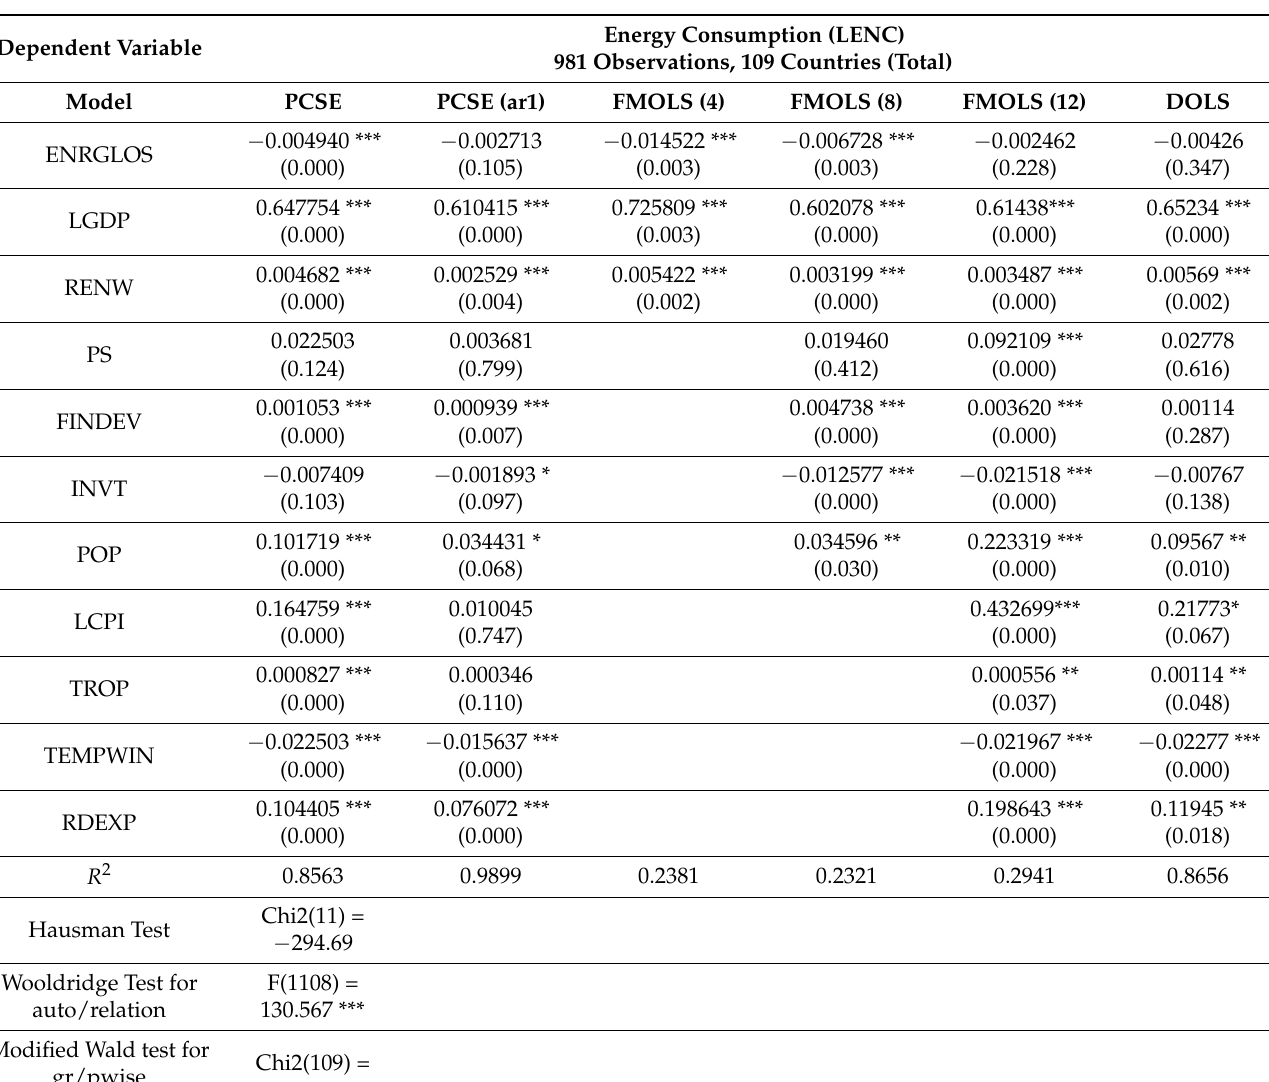
Table 4. Main results in the full model with error correction and FMOLS estimation